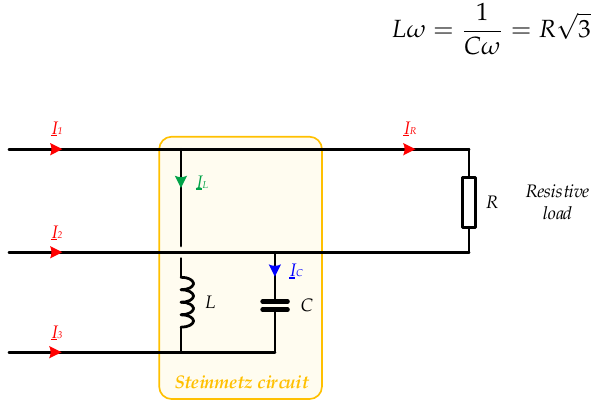
Figure 7. Basic principle of the Steinmetz balancing circuit.